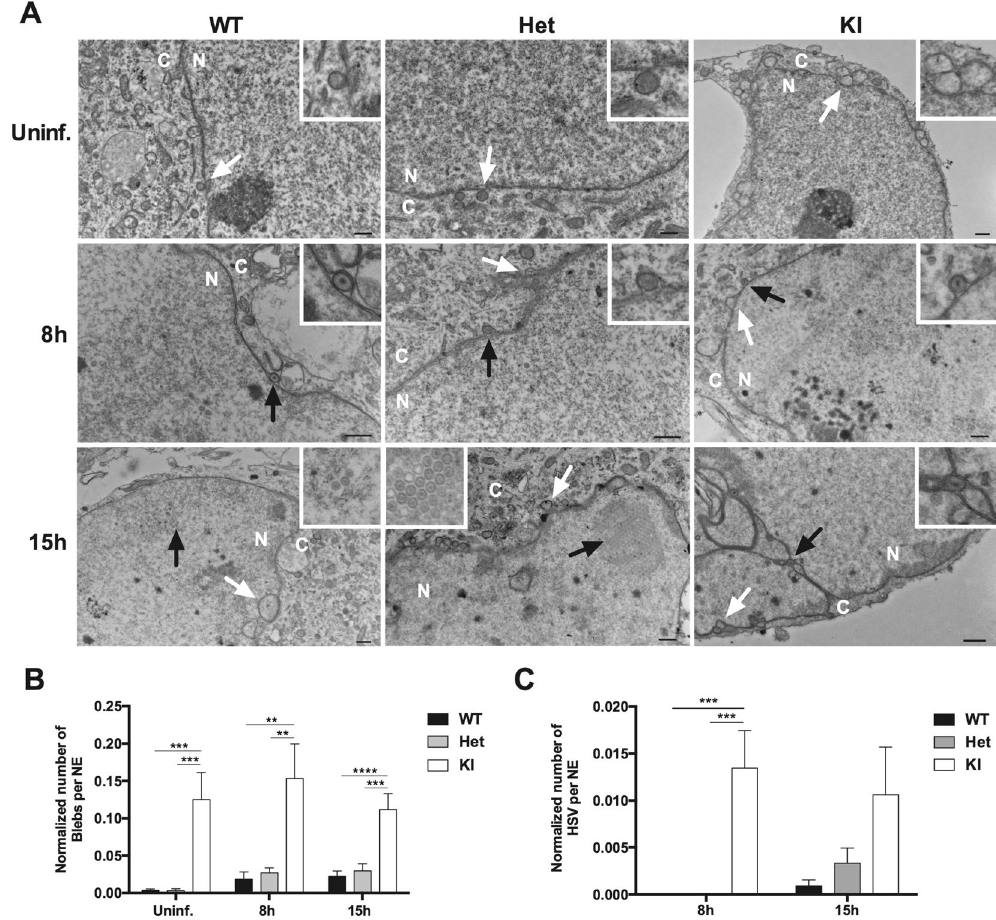
Figure 3. HSV infection and bleb formation in DYT1 neurons. ( A ) WT, Het, and KI neurons were uninfected (Uninf.) or infected with HSV-VP26-RFP (M.O.I. of 1) and imaged using an electron microscope at 8 h and 15 h post-infection. White arrows indicate blebs associated with the NE. Black arrows indicate HSV particles either associated with the NE (8 h and 15 h) or in the nucleus (15 h). Enlarged images in the top right corners represent the area indicated by white arrows (uninfected) or black arrows (infected). ( B ) At all three conditions (uninfected, 8 h and 15 h post-infection), KI neurons had significantly more blebs associated with the NE than WT (uninfected: p = 0.0002, n = 50; 8 h: p = 0.0022, n = 30; 15 h: p < 0.0001, n = 30) or Het cells (uninfected: p = 0.0002, n = 50; 8 h: p < 0.0045, n = 30; 15 h: p = 0.0003, n = 30). ( C ) HSV particles associated with the NE were counted from a total of 30 neurons for each condition. At 8 h post-infection, a significant difference was seen in the average number of HSV particles associated with the NE in KI neurons, as compared to WT (p = 0.0003) and Het (p = 0.0003). There was no significant difference among any of the samples at 15 h post- infection. ( B and C ) Number of blebs and HSV in NE was normalized by the length (perimeter) of the NE. Statistical significance was determined using one-way ANOVA followed by a post-hoc Tukey test. N: nucleus; C: cytoplasm. Scale bars: 500